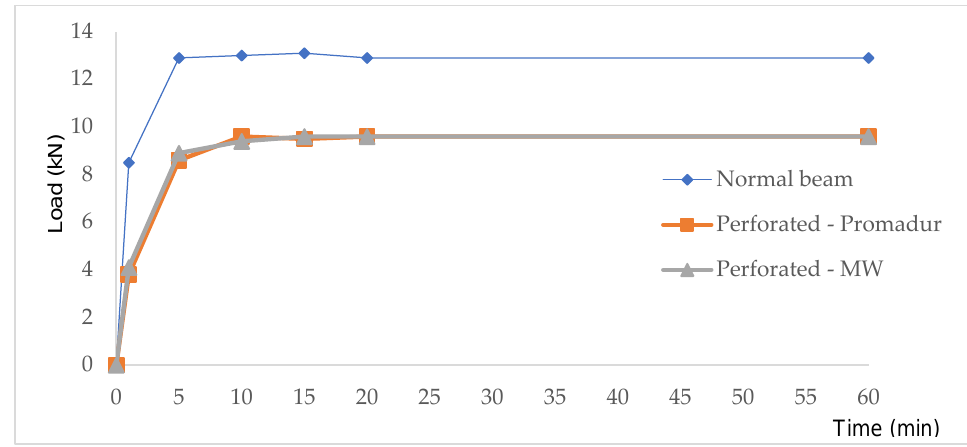
Figure 13. Loading protocol.